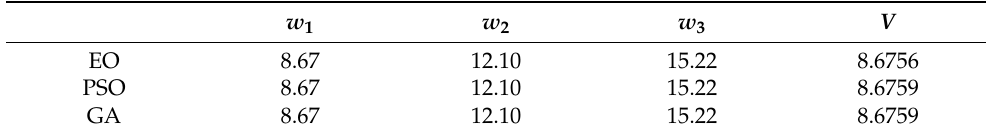
Table 7. Allocated tasks for the AUVs and the value of the goal function in the small-scale system under w total = 36 kg.